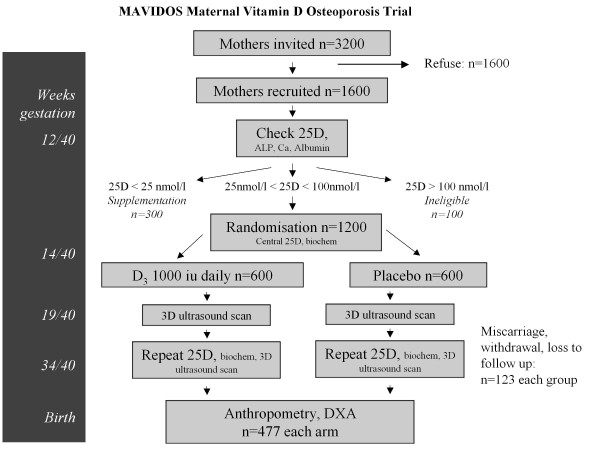
MAVIDOS trial outline, showing expected recruitment and withdrawal through study. Timings are given relative to the 40 week normal gestation.